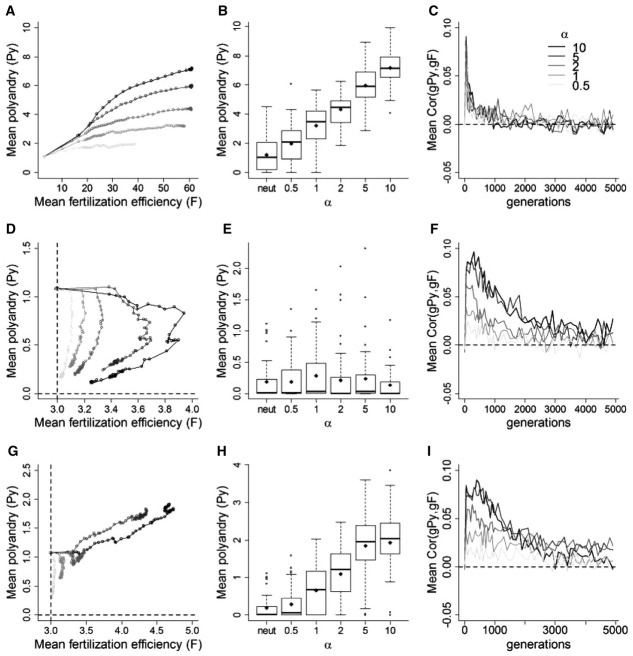
Effect of the strength of paternity bias (α) linking fertilization efficiency (F) to realized fertilization success on coevolution between polyandry (Py) and fertilization efficiency (F). (A) Mean phenotypic values for Py and F for different values of α in the absence of costs. α = 1 and α = 10 equate to “fair-raffle” and “winner-takes-all” fertilization, respectively. Gray circles indicate the simulation starting values. (B) Mean phenotypic values for Py and neutral traits (“neutral”) subject to the same strength of direct selection at generation 5000, for different values of α, described as medians (solid bands), first and third quartiles (box limits), approximately twice the standard deviation (whiskers), and means (diamonds). (C) Mean correlations between Py and F for different values of α. (D–F) Same as in (A–C) when costs are applied to both traits (ω2Py = 400.0 and ω2F = 1.0). (G–I) Same as in (D–F) when, additionally to costs, substantial negatively biased mutations are applied to F (m′ = −0.35). All data are averaged over 50 replicate simulations, plotted every 50 generations until generation 1000 and every 100 generations thereafter. Dashed lines in (D) and (G) indicate the traits’ optima.